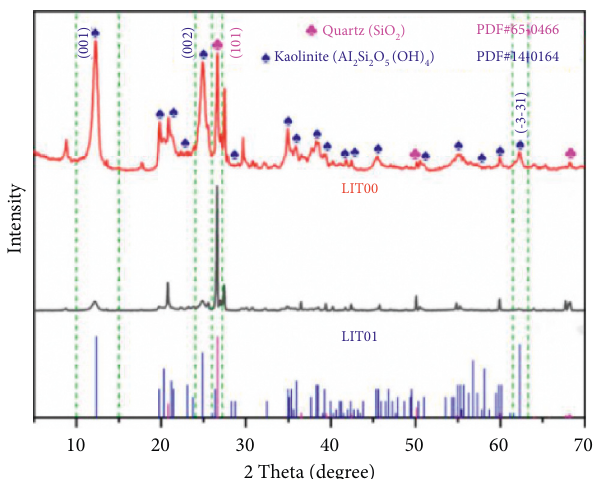
Figure 13: XRD patterns of LIT00 and LIT01.